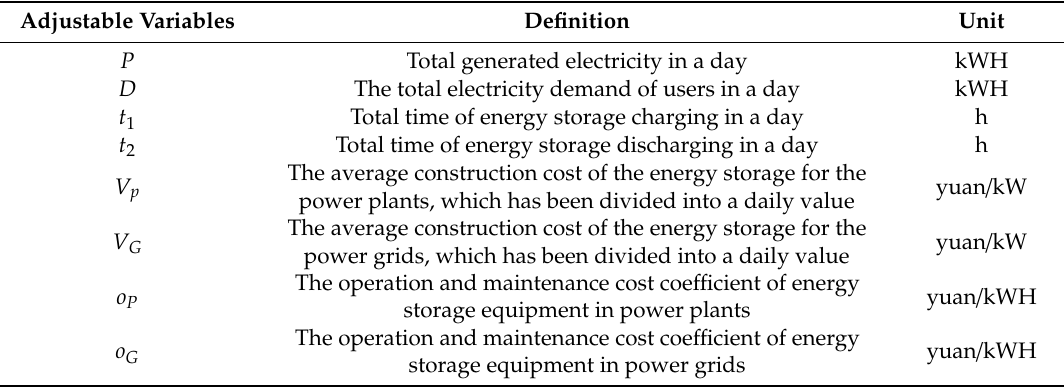
Table 3. Adjustable variables of the trilateral strategy evolution game.